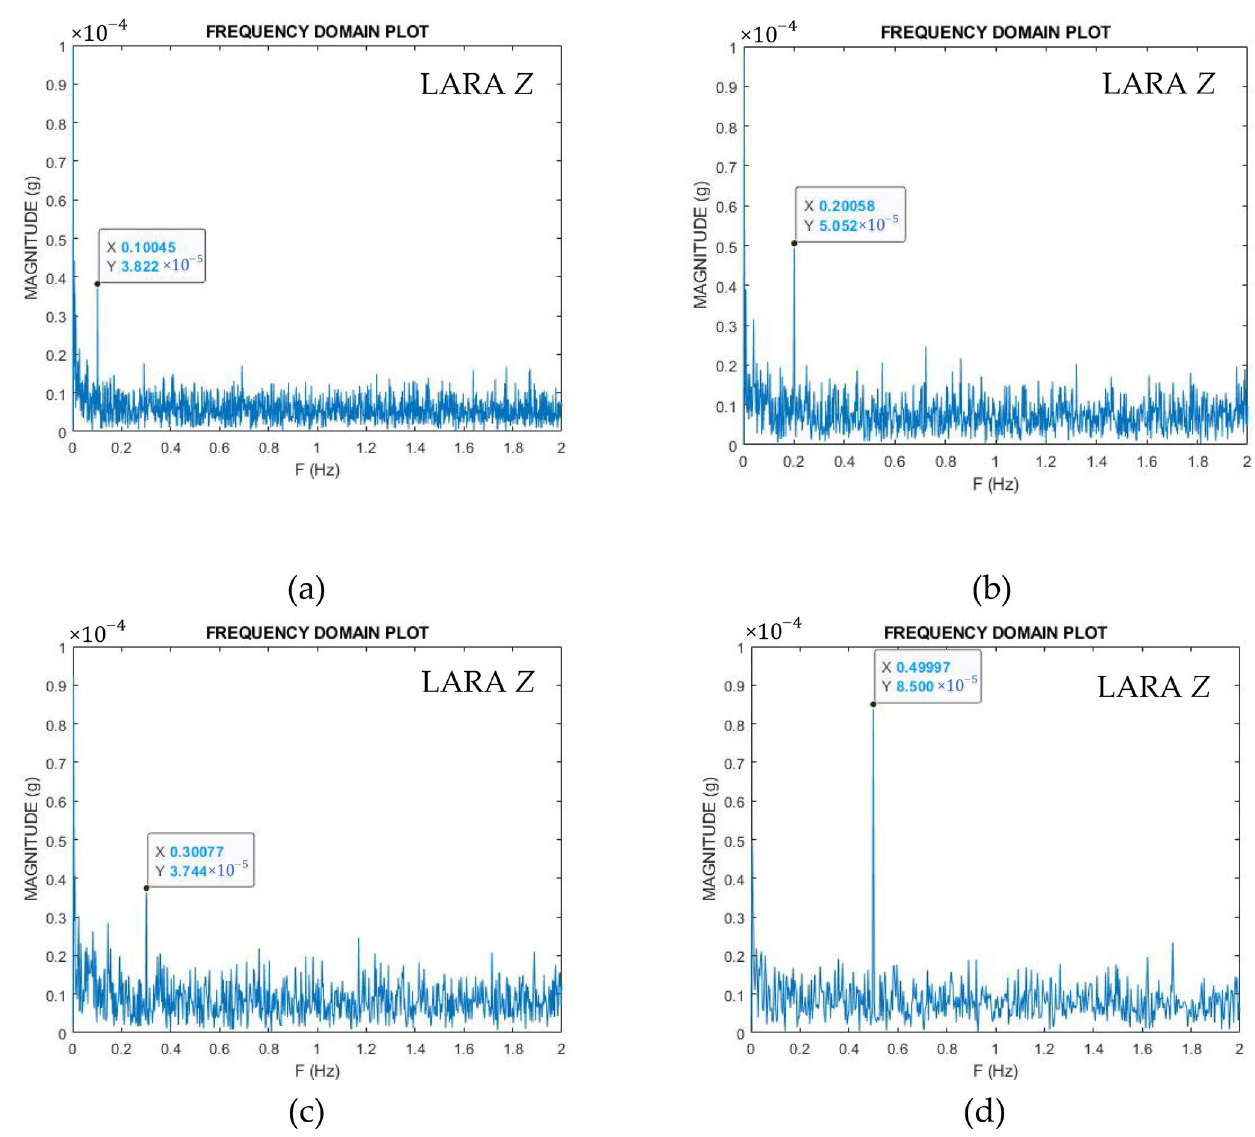
Figure 5. FFT representation of the low-frequency signals: ( a ) 0.1 Hz, ( b ) 0.2 Hz, ( c ) 0.3 Hz, and ( d ) 0.5 Hz.